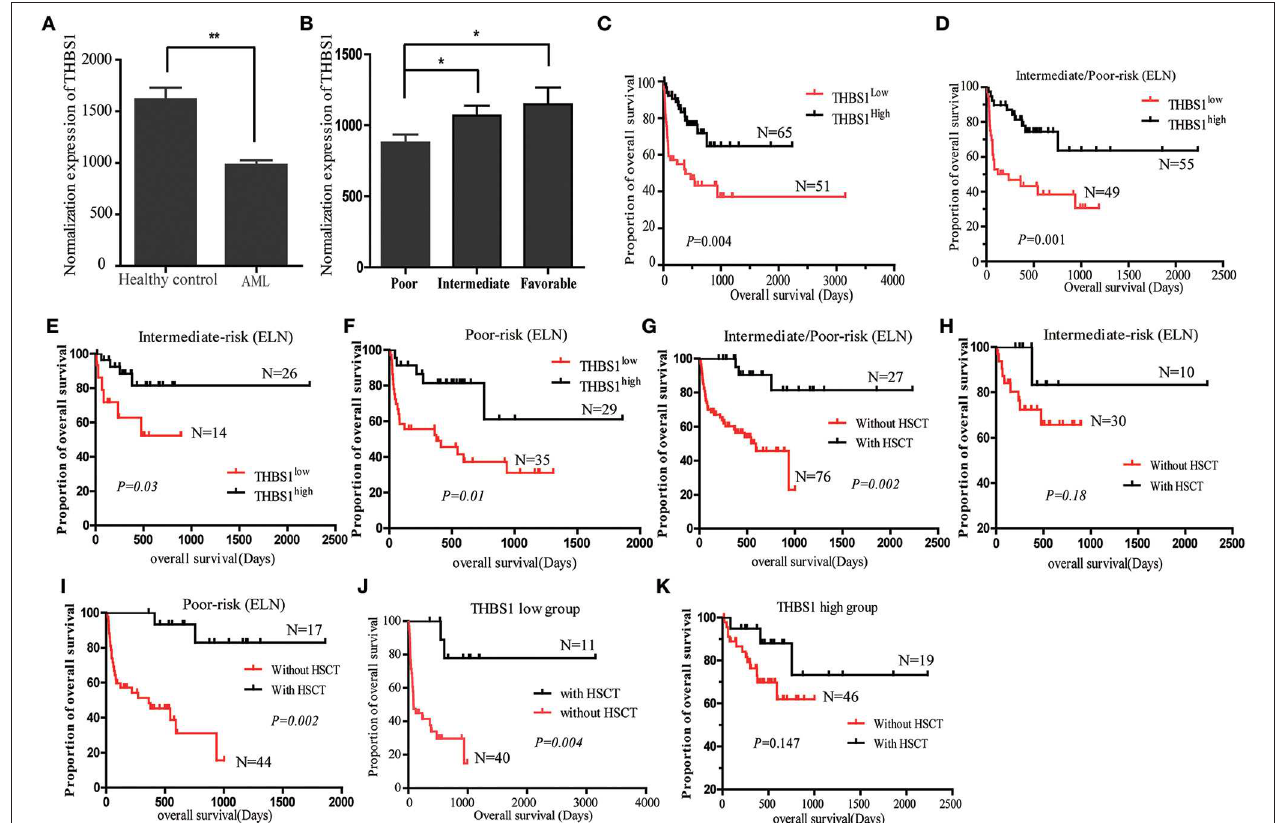
FIGURE 2 | Expression of THBS1 in the AML patients and normal control serum samples. (A) Expression level of THBS1 in 116 AML patients and 9 healthy controls. (B) Serum expression of THBS1 in AML patients with favorable, intermediate, and poor prognosis. (C) Kaplan–Meier survival curves estimated overall survival of patients with different expression of THBS1. (D–F) Kaplan–Meier estimated overall survival of serum THBS1 expression in patients with intermediate/poor prognosis, intermediate prognosis, and poor prognosis group. (G–I) Kaplan–Meier survival curves estimated overall survival of treatment with HSCT in patients with intermediate/poor prognosis, intermediate prognosis, and poor prognosis group. (J,K) Overall survival analysis of HSCT treatment in patients with high and low serum THBS1 expression patients. * P < 0.05, ** P < 0.01.